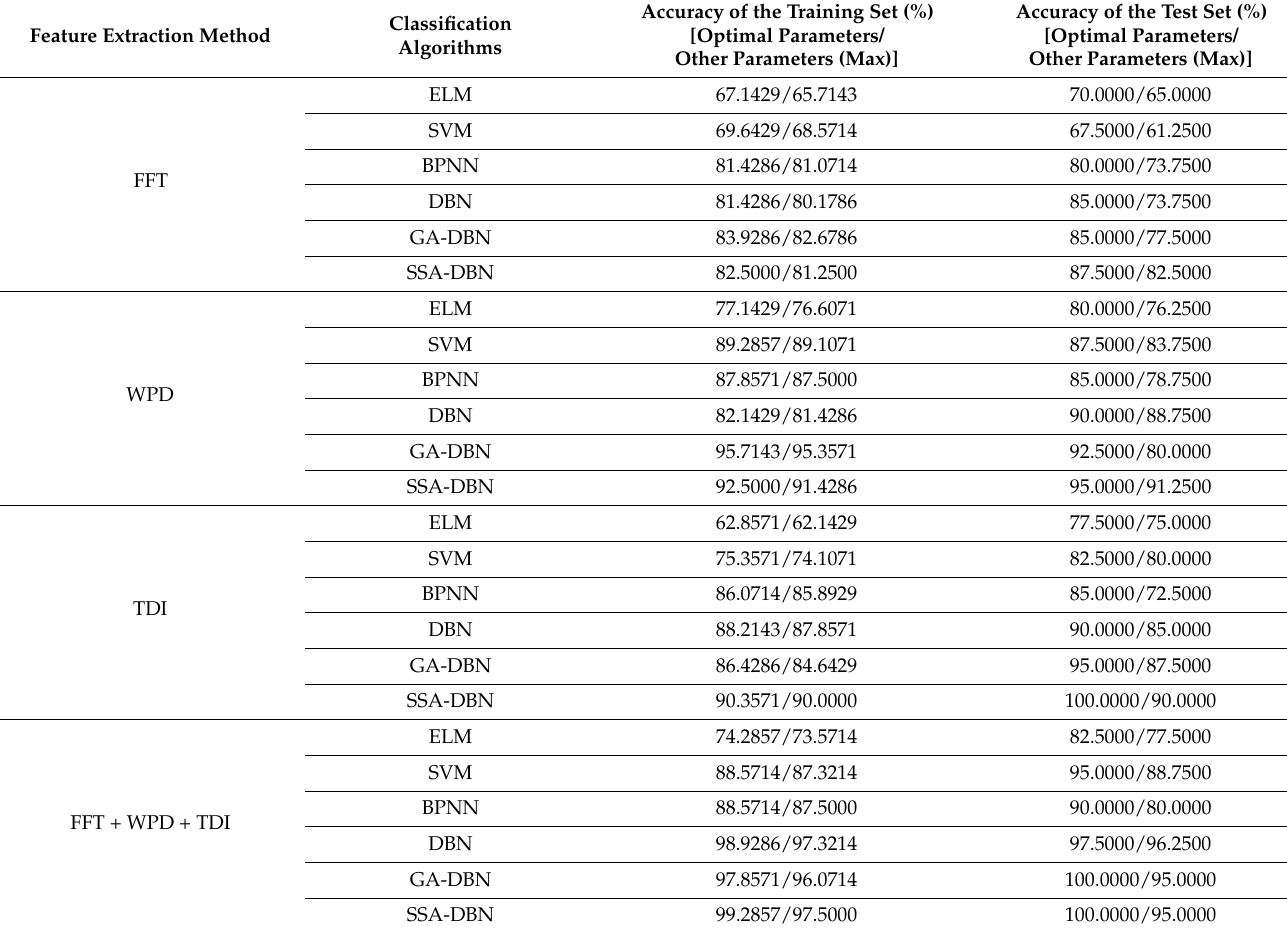
Table A3. The influence of parameter settings on the results of the on-load